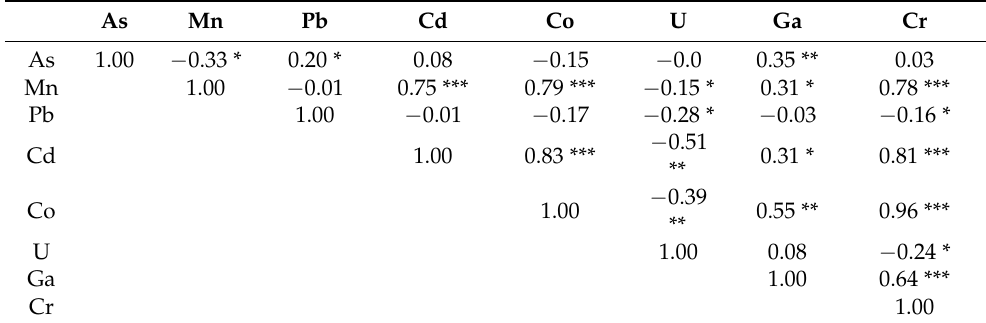
Table 2. Correlational relationship among metal(loids) detected in soil samples indicating correla- tional coefficients and levels of